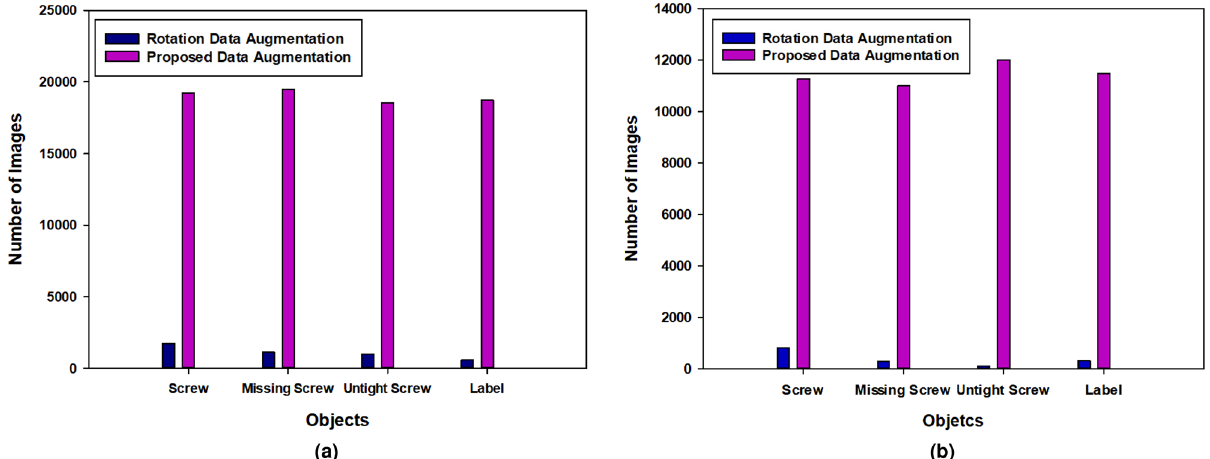
Figure 10. Comparison of the proposed data-augmentation method with rotation-augmentation technique. Left graph a shows the comparison results of the first trial, and right b graph show the comparison results of the second